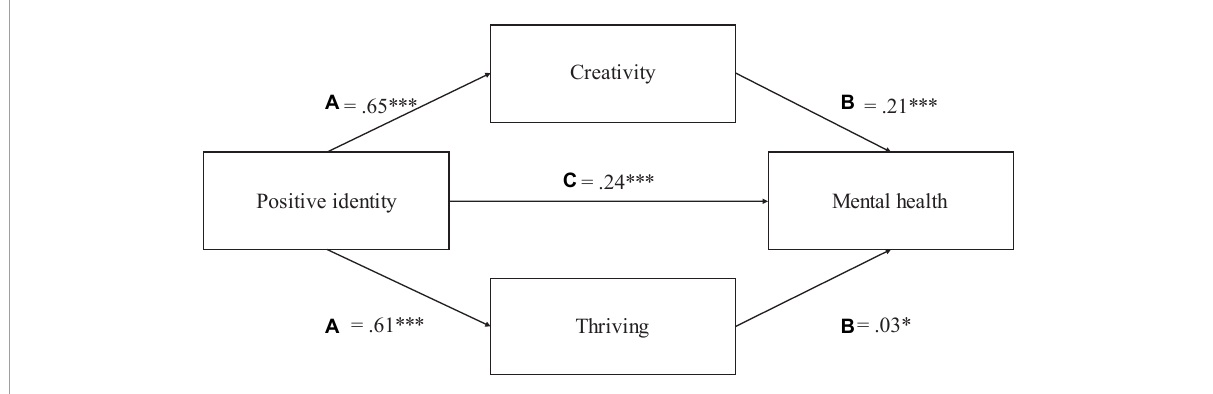
FIGURE2 The regression coefficients for path (A,B) were significant, representing effects of positive identity on creativity and thriving, and effects of creativity and thriving on mental health. The regression coefficient for path C was also significant. * meaning significance level as follow: * p < 0.05, *** p < 0.001.